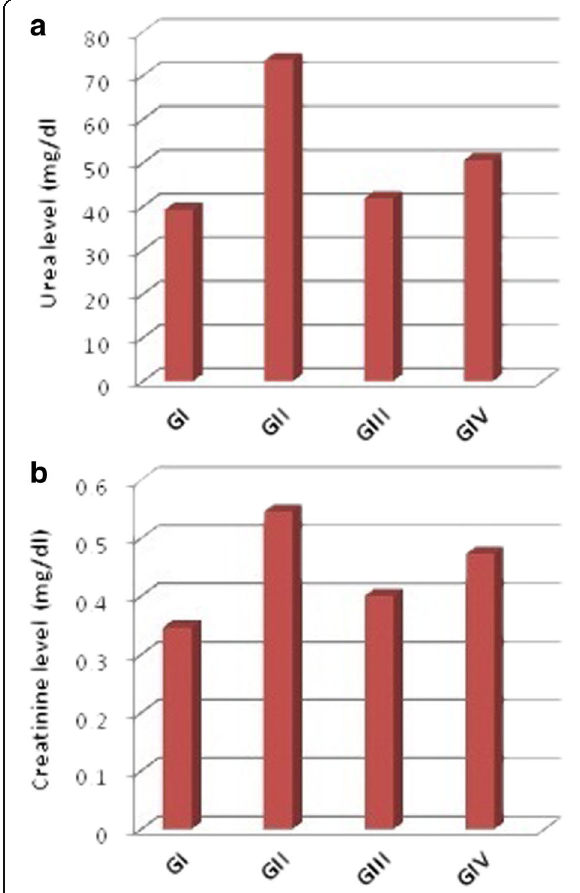
Fig. 4 Effects of olive leaf extract (OLE) and/or STZ administration on urea level ( a ) and creatinine level ( b ) in pregnant mice